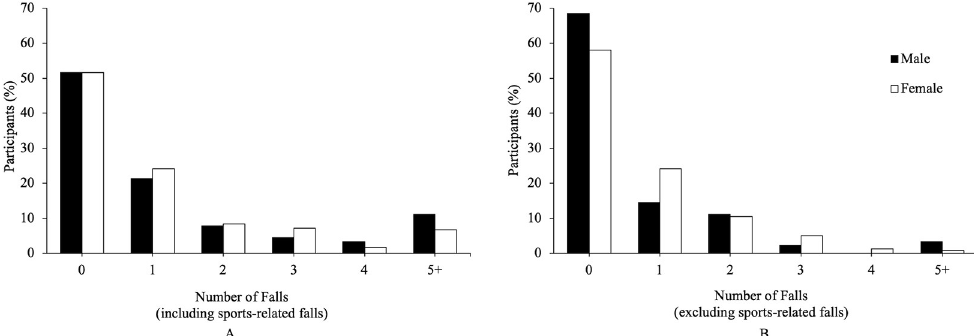
Fig 4. Percentage of participants versus the number of reported falls with sports-related falls included (A) and sports- related falls excluded (B). Eighteen participants with a response rate less than 35% are not included.